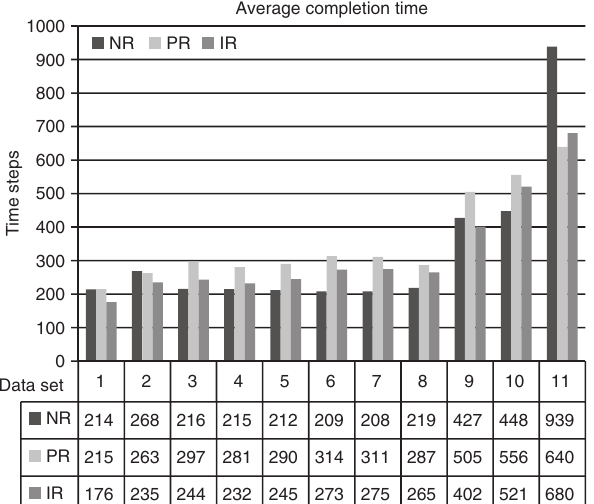
Figure 6. Average Task Completion Time by Data Set and Recognition Type.